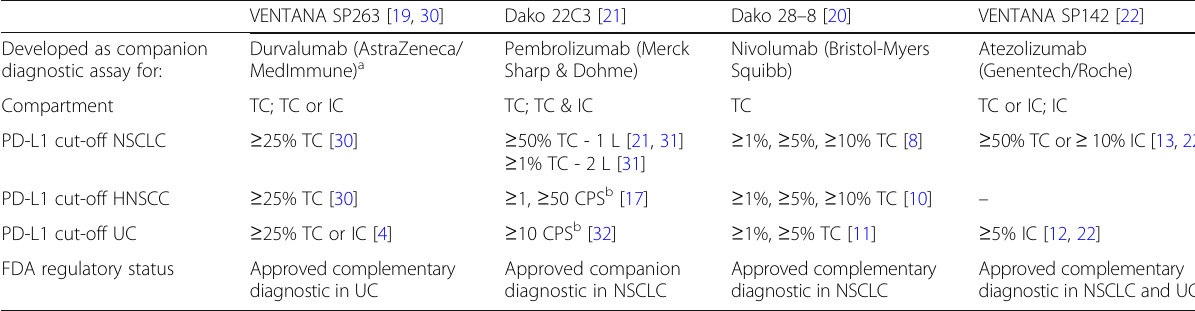
Table 1 Comparison of approved PD-L1 diagnostic assays and PD-L1 cut-offs in NSCLC, HNSCC and